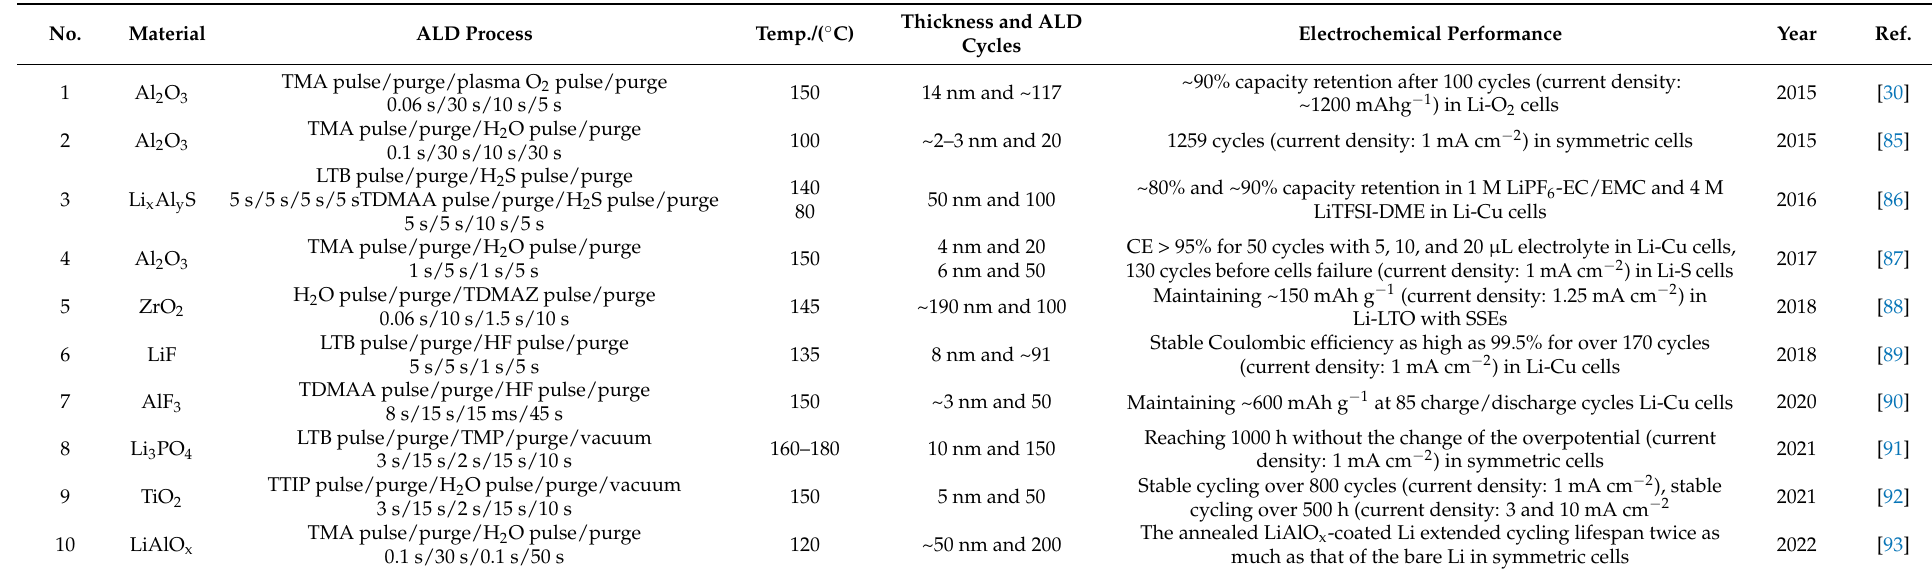
Table 1. Summary of ALD surface coating Li metal.